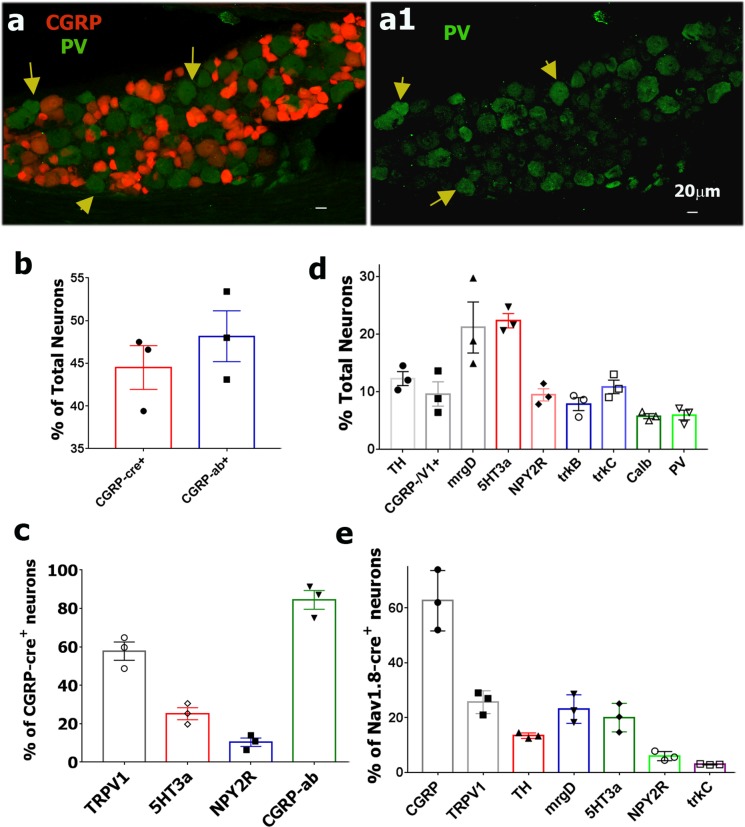
Expression pattern of sensory neuronal markers in CGRP-cre+ and Nav1.8-cre+ DRG neurons.a. Expression of parvalbumin (PV; green) relative to CGRP-cre+ DRG neurons (red). Yellow arrows mark CGRP-cre-/PV+ neurons (a and a1). White horizontal bar shows 20μm scale for each panel. b. Percentages of total L3-L5 DRG neurons labeled in CGRPcre-ER/+; Rosa26LSL-tDTomato/+ mice (i.e. CGRP-cre+), and with CGRP antibodies (i.e. CGRP-ab+). Cell counting is from three animals, 3–4 sections each. c. Percentage of CGRP-cre+ L3-L5 DRG neurons in CGRPcre-ER/+;Rosa26LSL-tDTomato/+ mice labeled with indicated neuronal markers. Cell counting is from three animals, 4–5 sections each. d. Percentages of total L3-L5 DRG neurons labeled with a variety of indicated sensory neuronal markers. Cell counting is from three animals, 3–5 sections each. e. Expression percentages of markers in Nav1.8-cre+ in L3-L5 mouse DRG neurons. Cell counting is from three animals, 3–5 sections each.